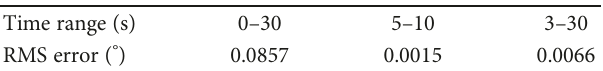
Figure 10: The response diagram of the FNN/PID controller under the step input. Table 1: The accuracy of the FNN/PID compound control scheme in di ff erent time periods.